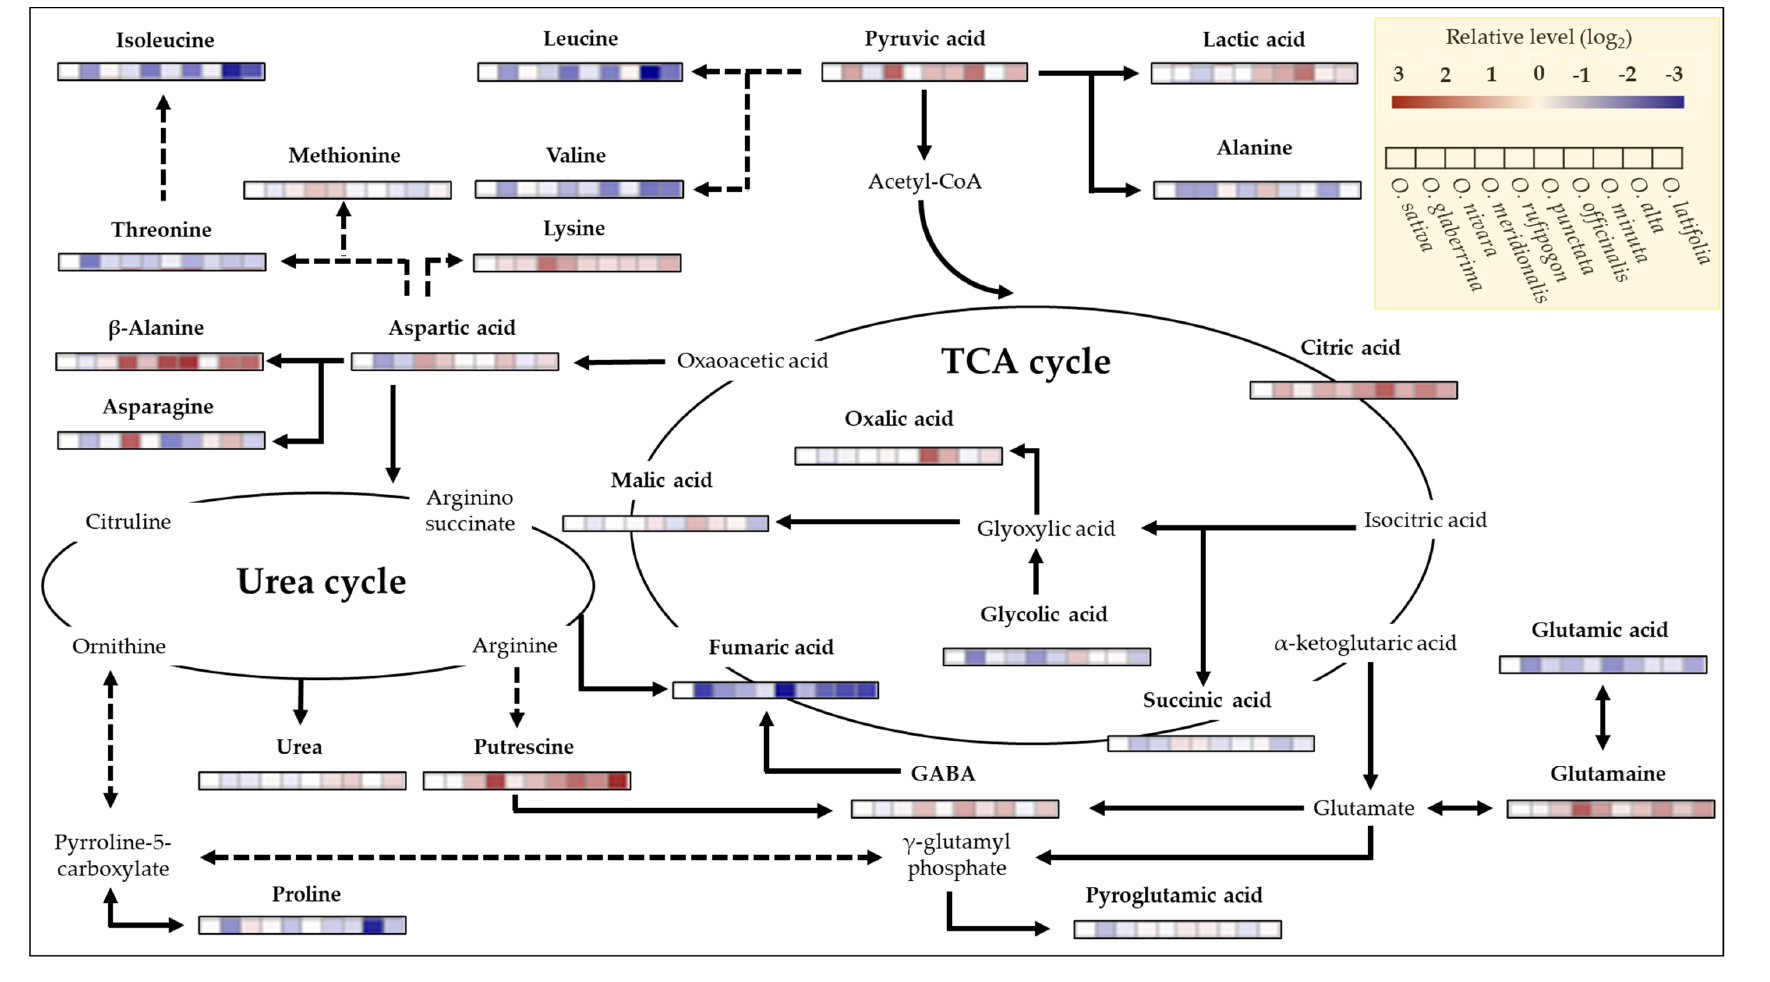
Figure 8. Mapping of targeted metabolites from the upper fully expanded leaves of rice species using GC-TOFMS (n = 3). Each color indicates relatively higher (red) and lower (blue) compared to O. sativa s sp. japonica cv. Saechucheongbyeo (RDA-Suwon433).